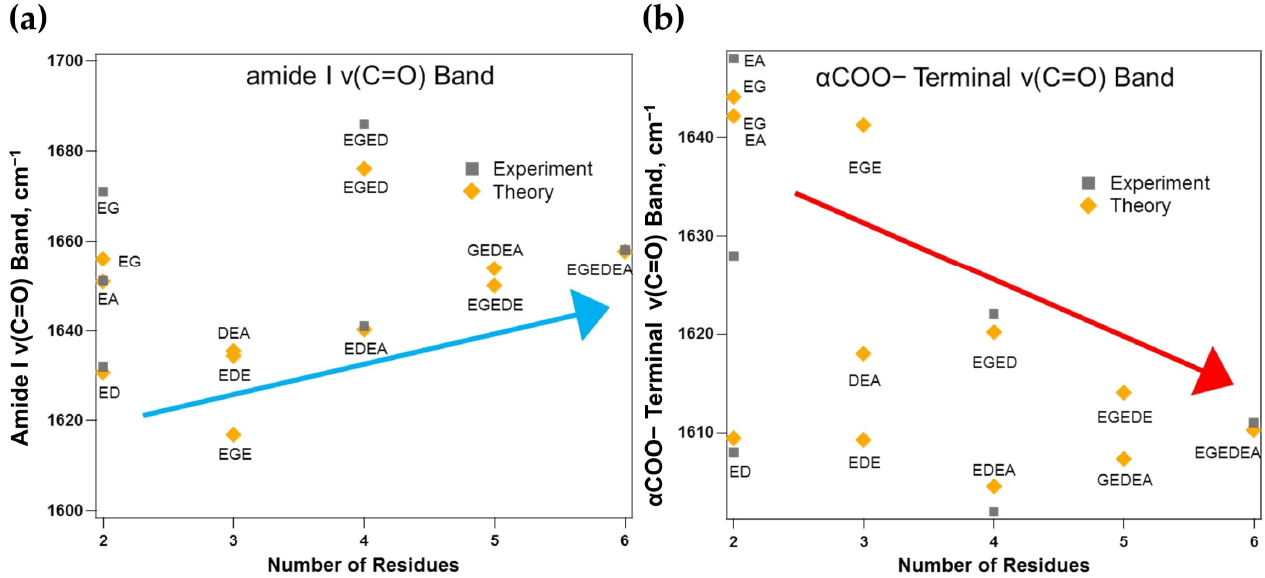
Figure 3. Correlation of the experimental Raman and Boltzmann-summed simulated band positions of the ( a ) amide I ν (C=O) vibration and ( b ) α COO − terminal ν (C=O) vibration as the length, n , of the peptide fragment increases from n = 2 to n = 6 amino acid residues. All vibrations are presented in wavenumbers, cm − 1 , and simulated spectra are computed at the B3LYP/6-311++G(2 df ,2 pd ) level of theory. The arrows are meant to serve as a visual guide for the trend and do not represent a linear